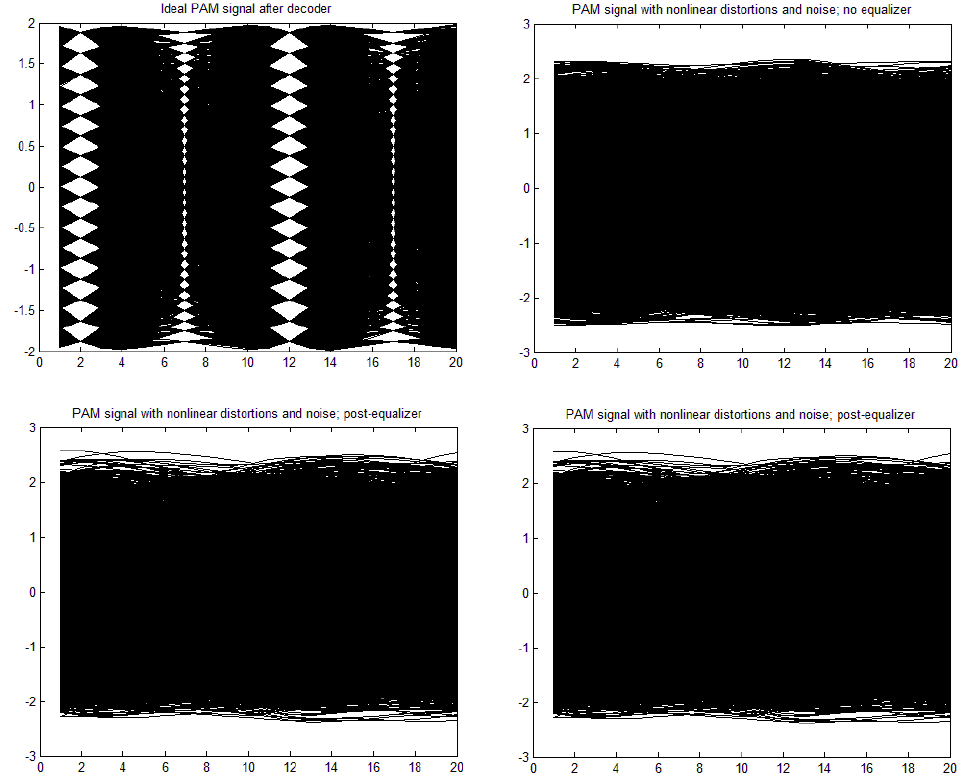
Figure 7. Eye patterns for PAM-8. Moderate nonlinearity: [1, − 0.1, 0.05, 0.02], and α = 1, SNR = 20 dB, and τ = 0.3T.